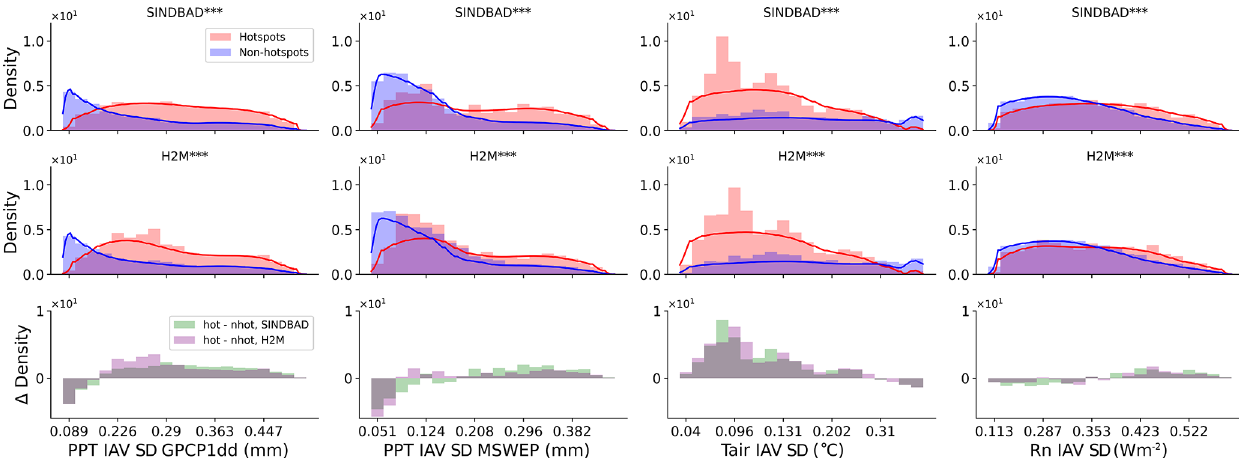
Figure B12. Same as Fig. 7 but for meteorological forcing variables, including the standard deviation (SD) of precipitation (PPT), interannual variation (IAV), air temperature IAV SD, and net radiation ( R n ) IAV SD. The first two columns from the left show results using different PPT data sets (GPCP1dd and MSWEP).